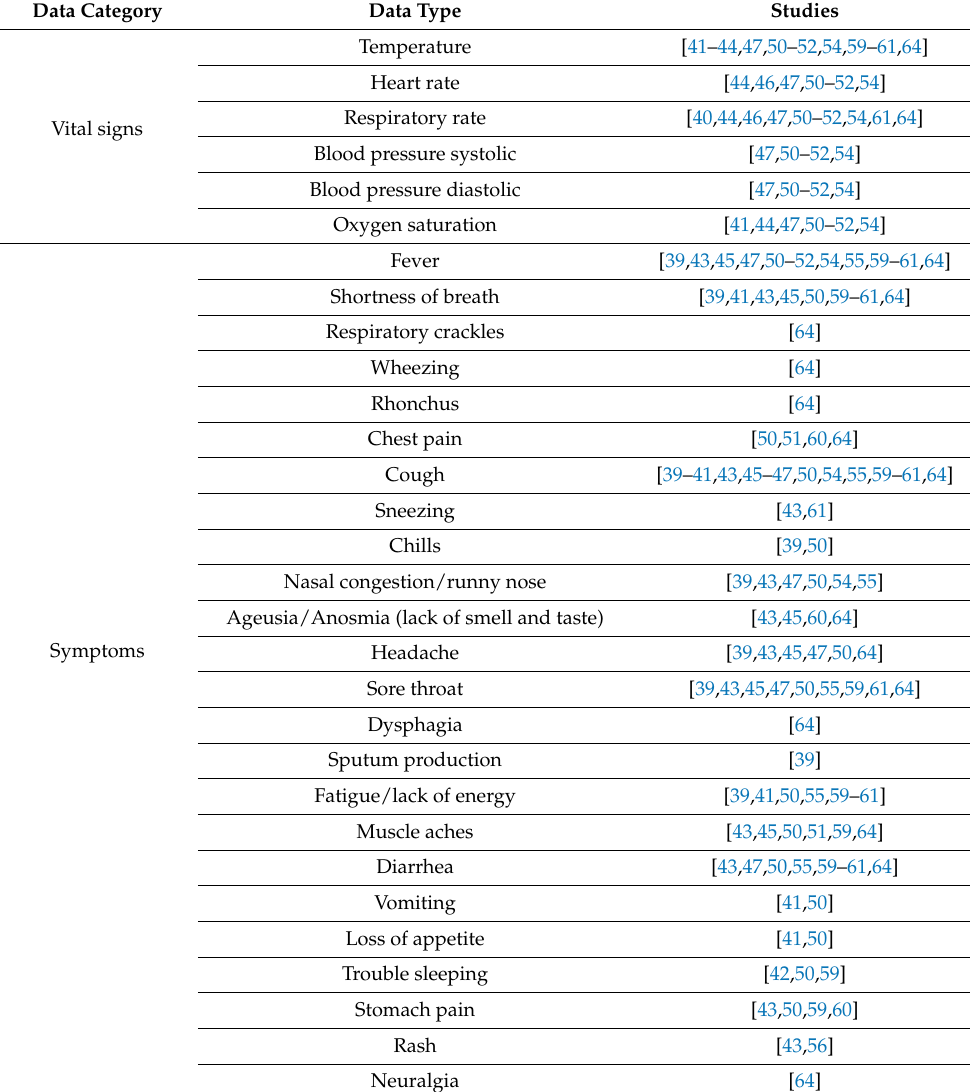
Table 7. Summary of vital signs and outwardly measurable symptoms considered by the existing